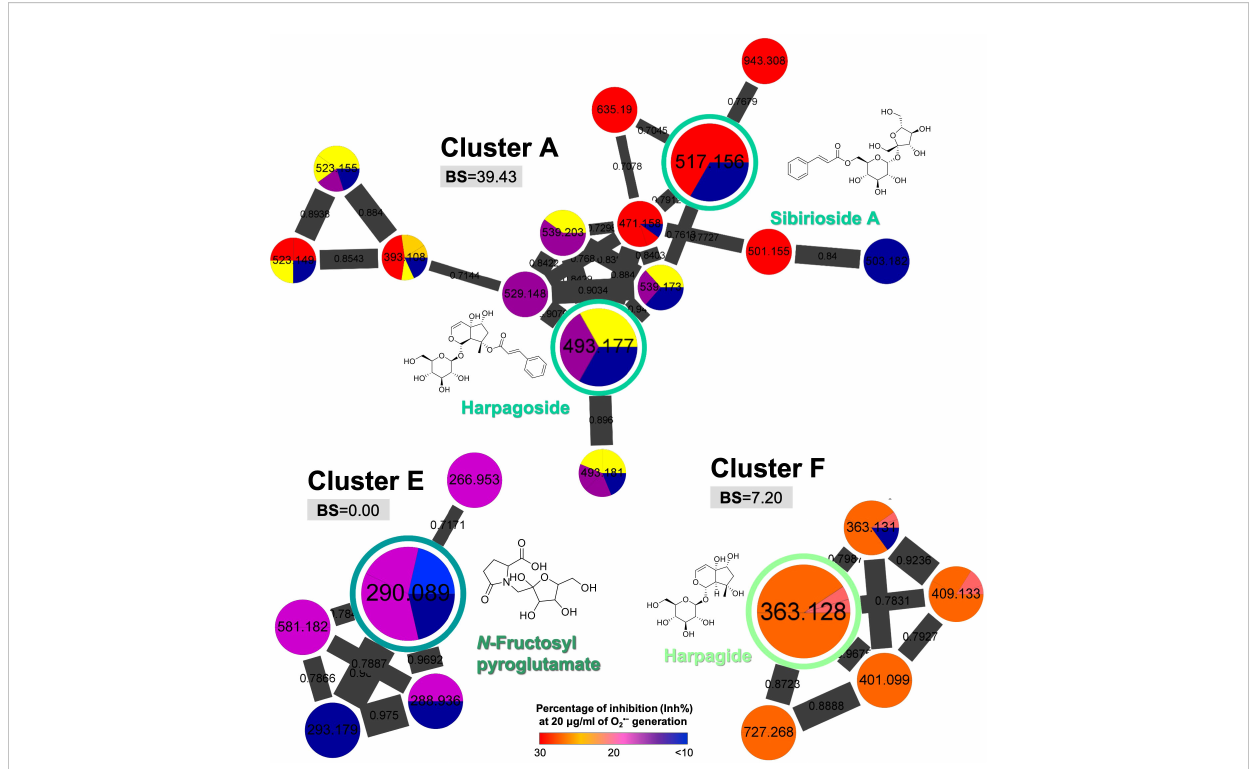
FIGURE 5 The selected MIMN clusters with low bioactive scores (BS < 50). The putative annotations were conducted based on the MS 2 matching from GNPS and Reaxys